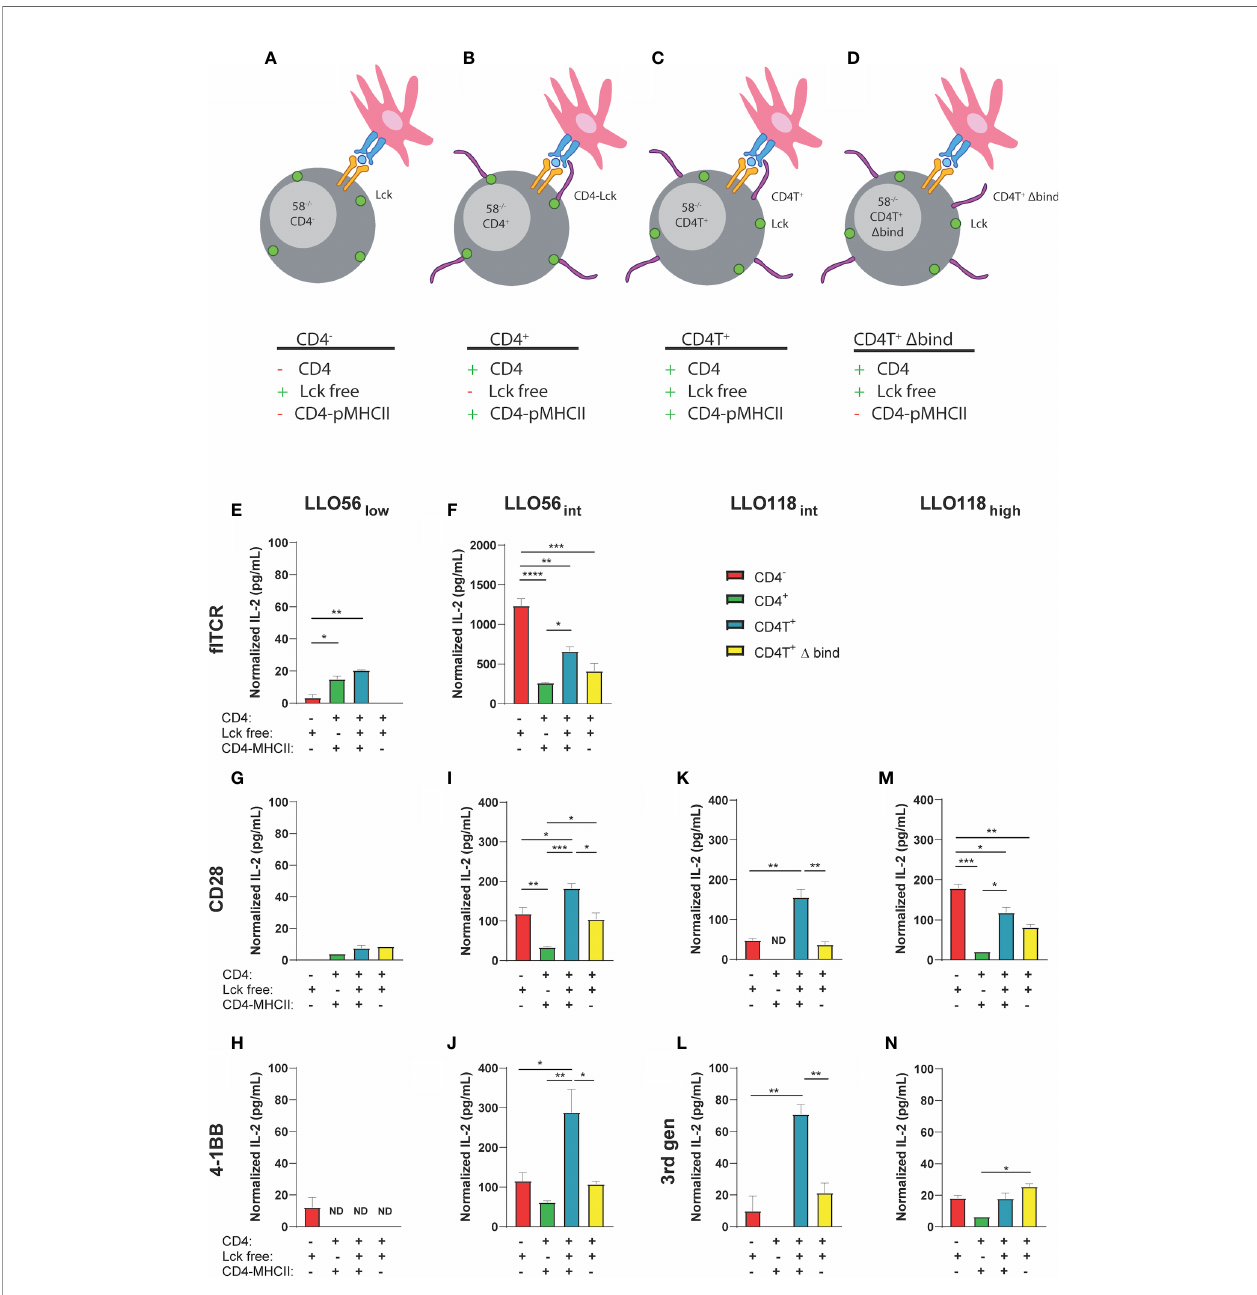
FIGURE 6 | IL-2 production of intermediate and high af fi nity clones is in fl uenced by Lck sequestration, CD4-MHCII interaction, and CD4 presence. (A) CD4 - has no CD4 and Lck is spread ubiquitously along the inner membrane. (B) CD4 + : wild type CD4 interacts with MHCII and the majority of Lck is sequestered to the cytoplasmic tail of CD4. (C) CD4T + : mutant CD4T interacts with MHCII but does not sequester Lck which is spread ubiquitously along the inner membrane. (D) CD4T + D bind: mutant CD4T D bind does not bind to MHCII nor Lck (Lck is not sequestered to the cytoplasmic tail of CD4). fl TCR and SCS-TCR constructs expressed in various T cell hybridoma clones [CD4 - (red), CD4 + (green), CD4T + (light blue), CD4T + D bind (yellow)] were incubated with 10 -3 M LLO 190-205 presented on Bl6.C57 splenocytes for 24 h. IL-2 production was measured by ELISA and normalized by subtracting IL-2 production without peptide for each clone-APC pair. Histogram order: LLO56 low (E) and LLO56 int (F) fl TCRs; LLO56 low (G), LLO56 int (H), LLO118 int (I) , and LLO118 high (J) CD28 TCR-SCS; LLO56 low (K) and LLO56 int (L) 4-1BB SCS-TCR ; LLO118 int (M) , and LLO118 high (N) 3 rd gen TCR-SCS. p-values were determined by multiple comparison one-way ANOVA for each graph are from left to right LLO56 int 4-1BB CD4 - to CD4T + (p = 0.0176), CD4 + to CD4T + (p = 0.0036), and CD4T + to CD4T + D bind (p = 0.0138); LLO56 int CD28 CD4 - to CD4 + (p = 0.0054), CD4 - to CD4T + (p = 0.0232), CD4 + to CD4T + (p = 0.0002), CD4 + to CD4T + D bind (p = 0.0245), and CD4T + to CD4T + D bind (p = 0.0153); LLO118 int 3 rd gen CD4 - to CD4T + (p = 0.0027), and CD4T + to CD4T + D bind (p = 0.0077); LLO118 int CD28 CD4 - to CD4T + (p = 0.0018), and CD4T + to CD4T + D bind (p = 0.0010); LLO118 high 3 rd gen CD4 + to CD4T + D bind (p = 0.0366); and LLO118 high CD28 CD4 - to CD4 + (p = 0.0010), CD4 - to CD4T + (p = 0.0221), CD4T - to CD4T + D bind (p = 0.0021), and CD4 + to CD4T + (p = 0.0117). *<0.05, **<0.01, ***<0.001,